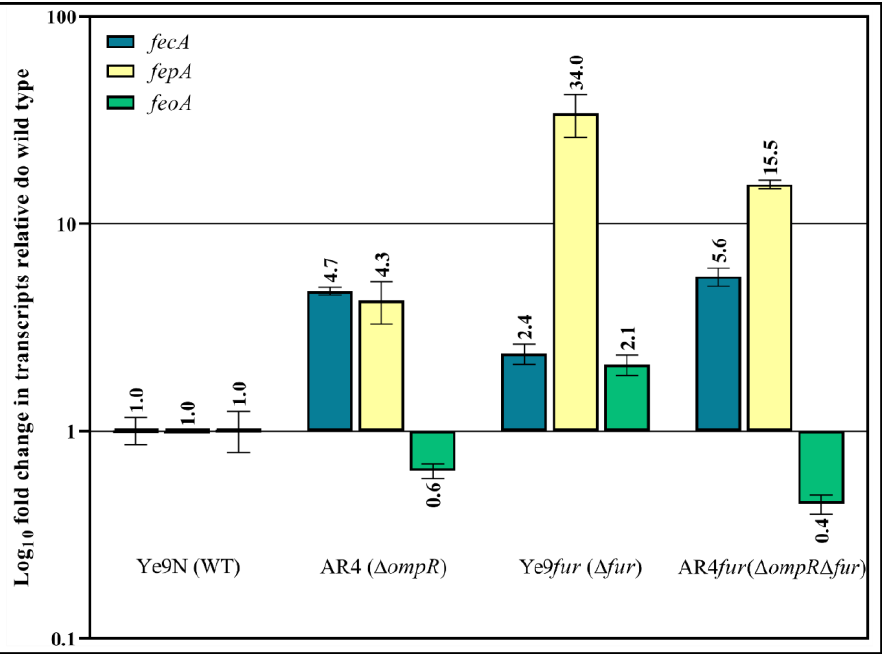
Figure 10. OmpR- and Fur-dependent regulation of fecA, fepA and feoA transcription in Y. enterocolitica Ye9N. Effect of OmpR on Fur regulon members expression determined by RT-qPCR. This analysis was performed using RNA prepared from cells of the wild-type strain (Ye9N), the Δ ompR mutant (AR4), the Δ fur mutant (Ye9 fur ) and the double Δ fur Δ ompR mutant (Ye9 furompR ), grown to early stationary phase in LB medium. Relative fecA, fepA, feoA and ftnA transcript levels, normalized to the amount of 16S rRNA, are shown, taking the mRNA level in Ye9N as 1. The mean value and SD obtained from at least three independent experiments are indicated for each strain.